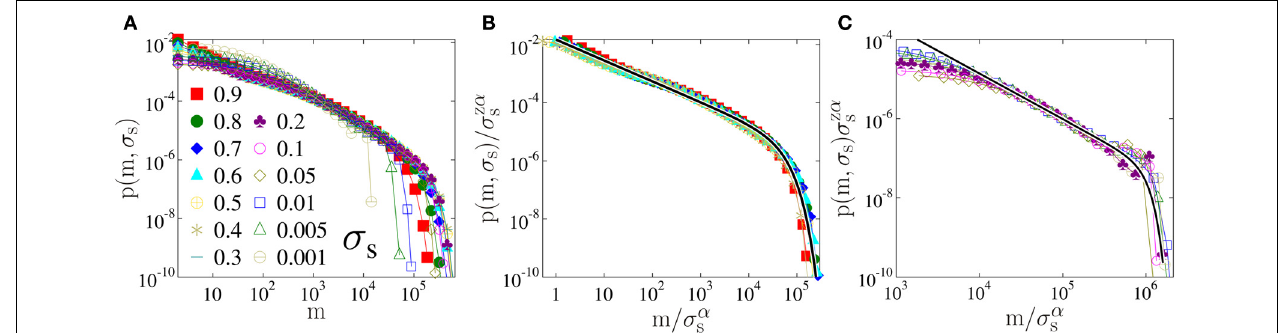
FIGURE 5 | (A) Probability distribution of waiting times p ( m , σ s ) between consecutive records for several values of the external load σ s . In (B,C) the same distributions are presented after rescaling the two axis with powers of